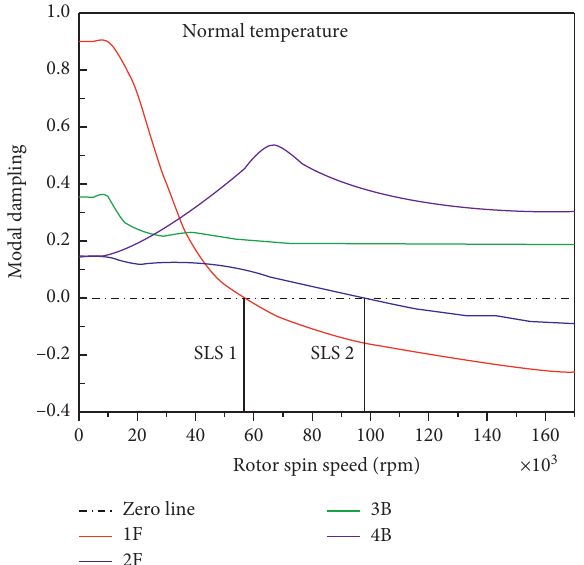
Figure 16: Stability diagram of rotor-shaft system without considering